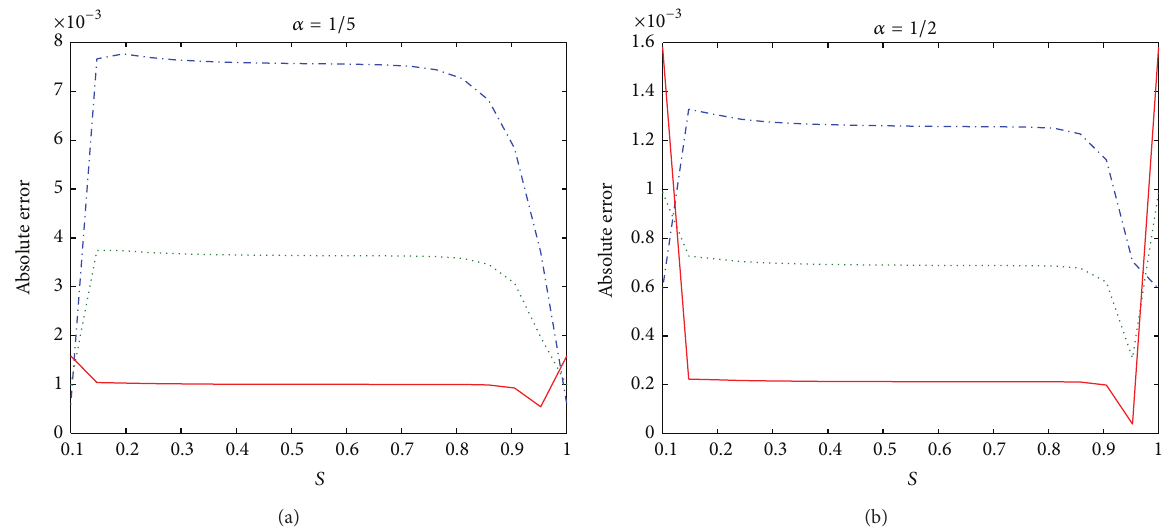
Figure 2: Absolute error between numerical solution and analytical solution. dash-dotted line: 𝑡 = 0.3 ; dotted line: 𝑡 = 0.5 ; solid line: 𝑡 = 0.8 .